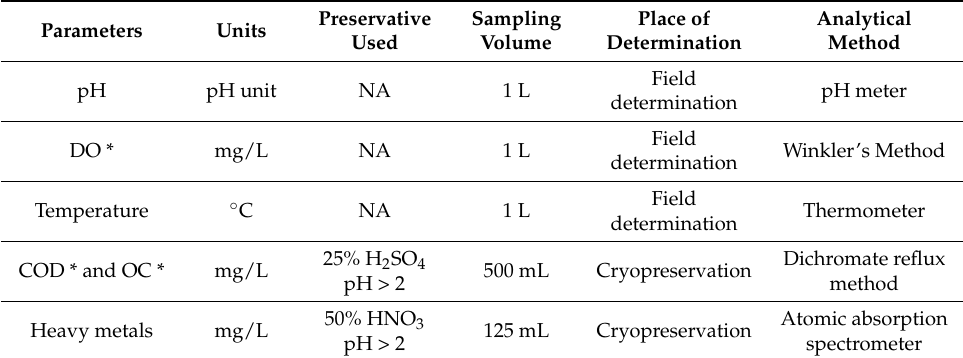
Table 1. Water parameters measured, units and method used for the analysis.